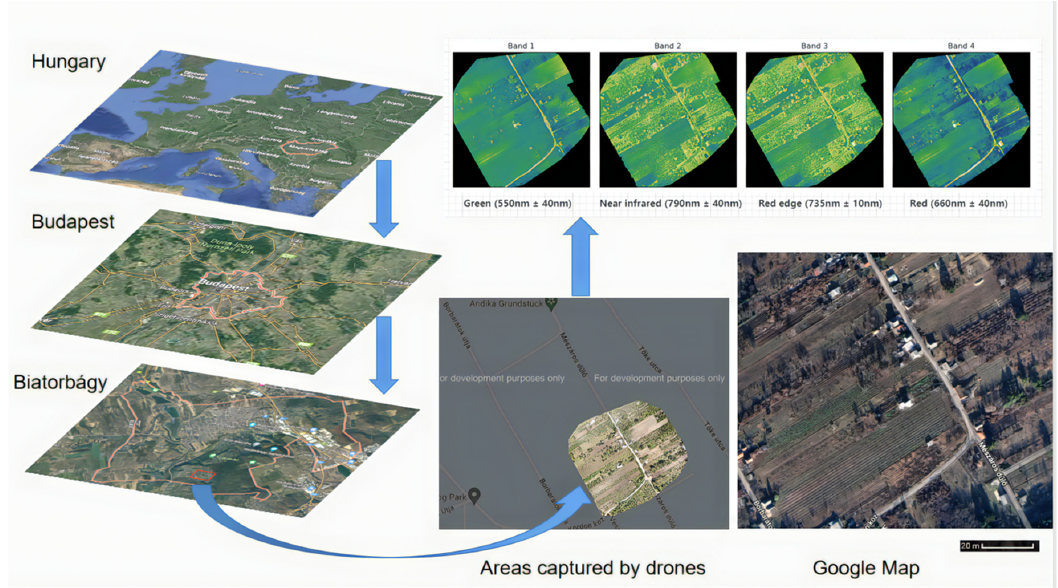
Figure 2. UAV with Parrot Sequoia+ multispectral camera dataset (The location is Biatorbágy, Bu- dapest, Hungary).